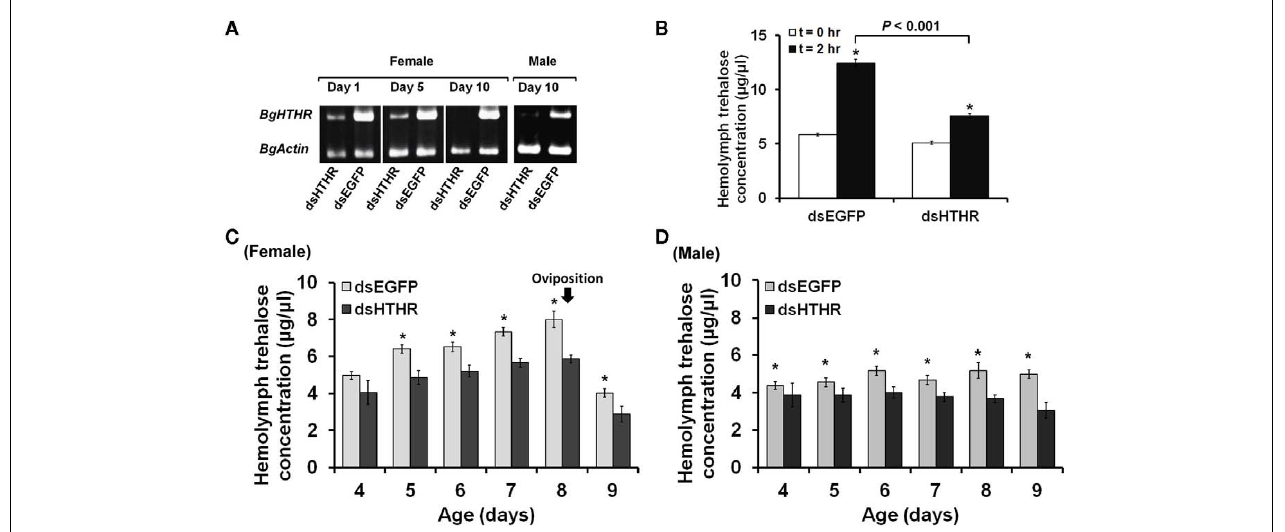
2h after HTH treatment. *Indicates significant differences between 0 and 2h after HTH treatment ( P < 0.05, two-tailed Student’s t -test). (C) Pattern of hemolymph trehalose in dsHTHR-treated adult females during the first reproductive cycle ( n = 8, except at the age of 4days, where n = 4). (D) Pattern of hemolymph trehalose in dsHTHR-treated adult males ( n = 6). * P < 0.05 is using two-tailed Student’s t